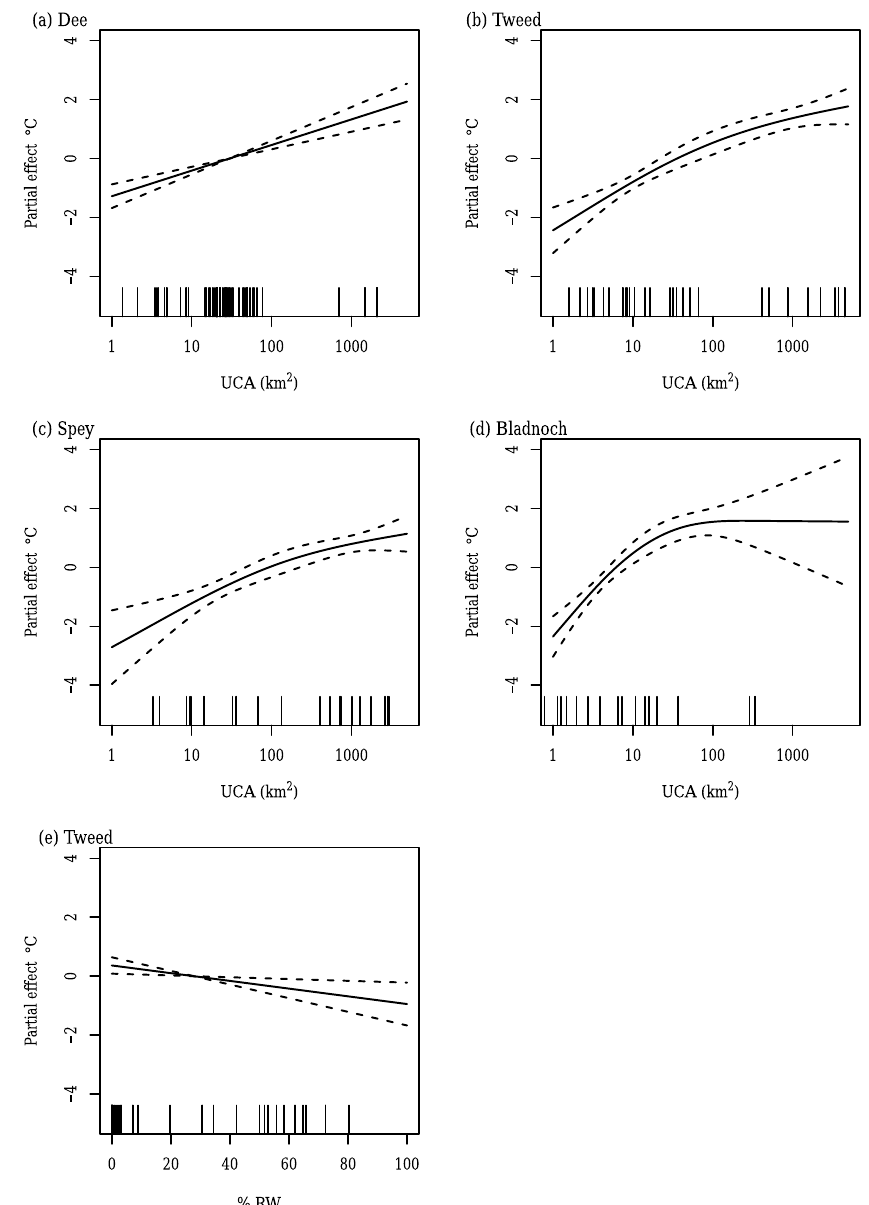
Figure 3. LS model effects with pointwise 95% confidence bands: (a) Dee UCA, (b) Tweed UCA, (c) Spey UCA, (d) Bladnoch UCA and (e) Tweed